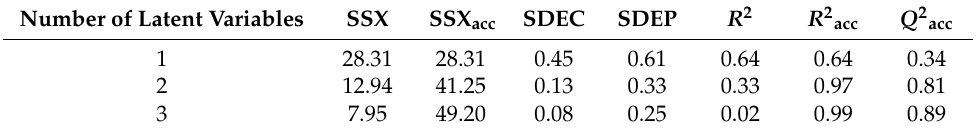
Statistics of PLS model for Leishmania amazonesis arginase. Legend: SSX—X variable explanation; SSX acc —X accumulation; SDEC—Standard Deviation of Error of